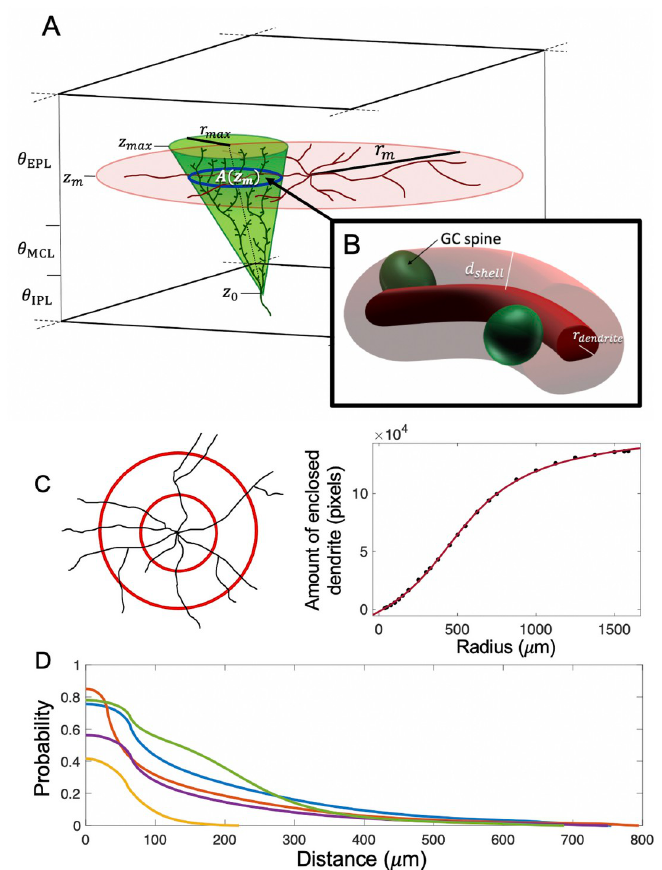
Fig 1. Schematic of the model. ( A ) Our model olfactory bulb (OB) has three layers: the external plexiform layer (EPL), mitral cell layer (MCL), and internal plexiform layer (IPL), each with a specified thickness. We modeled mitral cells (MCs) as flat disks with radius r (indicated in red), placed at at a height z in the EPL. We modeled granule cells m m (GCs) as inverted oblique circular cones (indicated in green), with bottom vertex at z 0 in the MCL or IPL, and top face at z max in the top half of the EPL; the radius of the top face was r max . By integrating the MC lateral dendrite density ρ m ( r ) over the area of intersection A ( z m ) between the MC disk and GC cone, we calculated the length of MC lateral dendrite contained in the overlap. ( B ) By treating the lateral dendrites as cylinders, we calculated the potential volume of interaction between MC lateral dendrite and GC spines around the length of MC lateral dendrite in the overlap. Presuming that GC spines are roughly evenly distributed at any given height along the cone, such that the spine density ρ g depends only on z , and that this density is roughly constant over the thickness of the MC disk, the expected number of spines in the interaction volume (which we treat as equivalent to the expected number of synapses) was ρ g ( z ) multiplied by the volume. ( C ) We utilized camera lucida images of MCs to calculate the total amount of dendrite within circles of increasing radii and found that this quantity was well fit by an equation α tan − 1 ( kr + β ) + C (mock MC shown). The equation for the density of lateral dendrites ρ m ( r ) was derived from this. For example, a cell image from [41] was well fit by the function with α = 66, 270, k = 0.002609, β = − 1.159, and C = 55, 010 ( r 2 value = 0.9998). ( D ) Sample connection probability curves as a function of distance for different MC/GC pairs, where the connection probability is the probability of at least one synapse existing between a MC-GC pair. This is determined by using the expected number of synapses between that pair as the mean of a Poisson